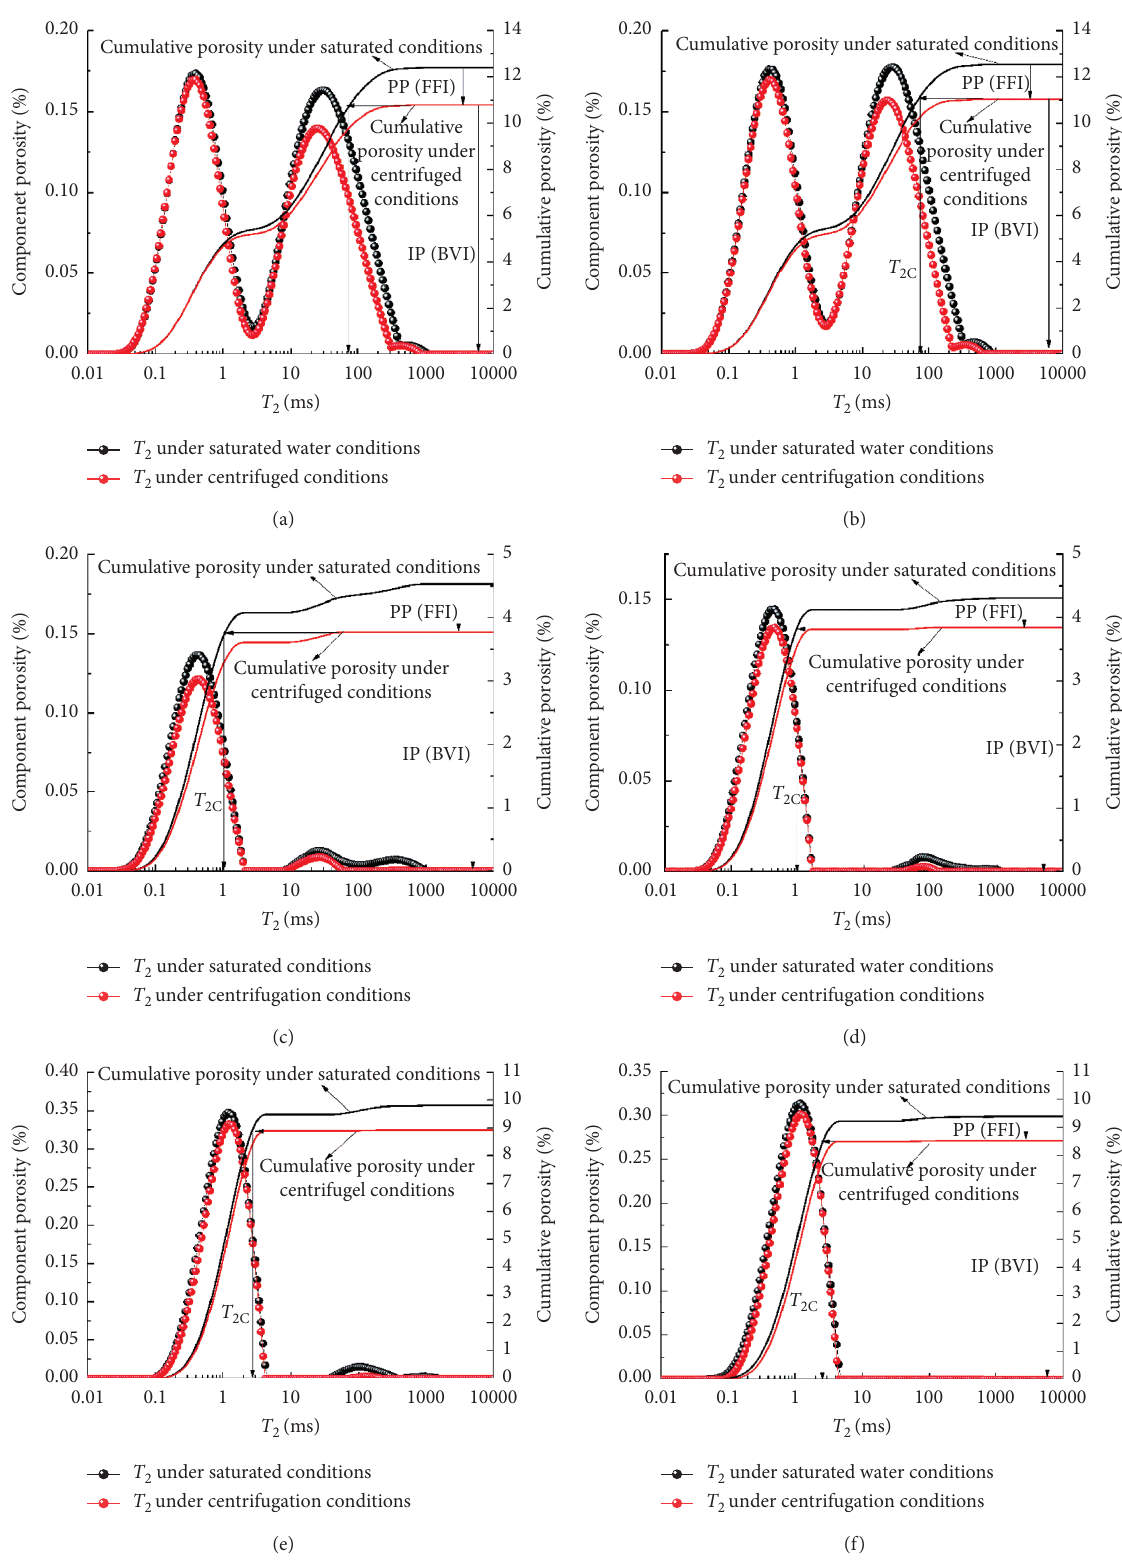
2c . (a) XJ-1, (b) XJ-2, (c) HB-1, (d) HB-2,